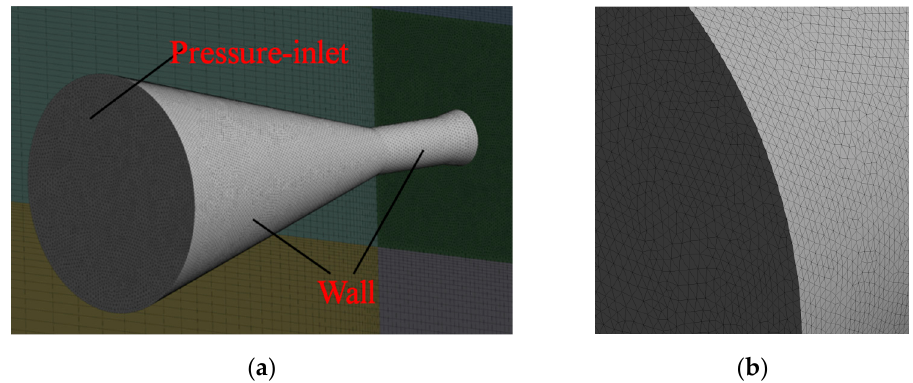
Figure 3. Simulation Model of the nozzle: ( a ) unstructured grid of the nozzle; ( b ) detail view of unstructured